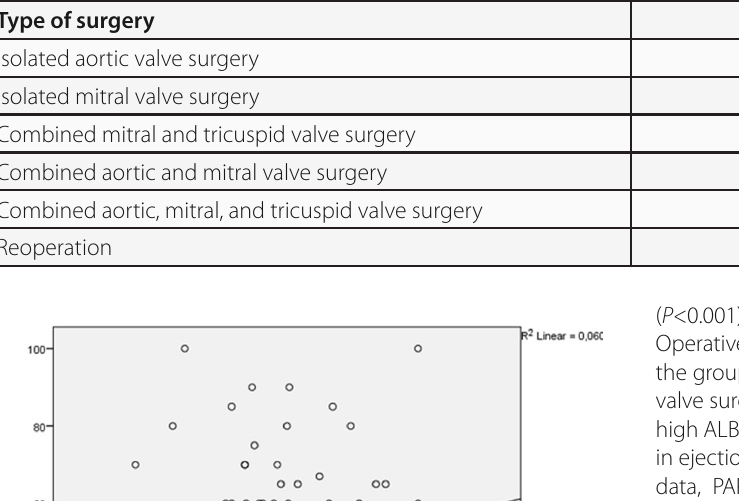
Table 1. Distribution of operation types.